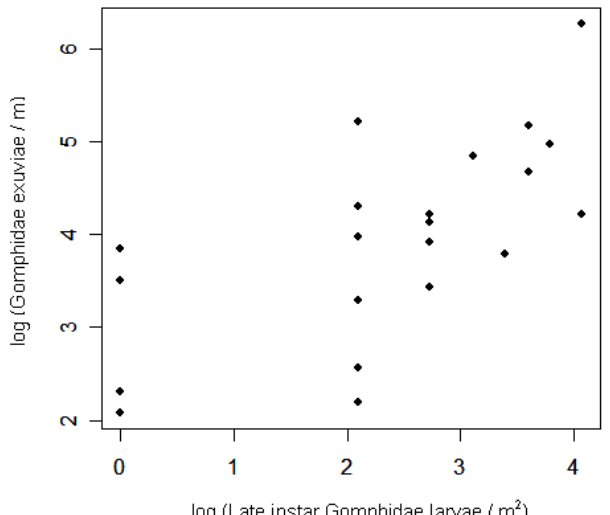
Figure 4. Gomphidae exuviae densities as a function of larval densities from the second year-class sampled earlier during the same year (2006) at 22 north-temperate lake